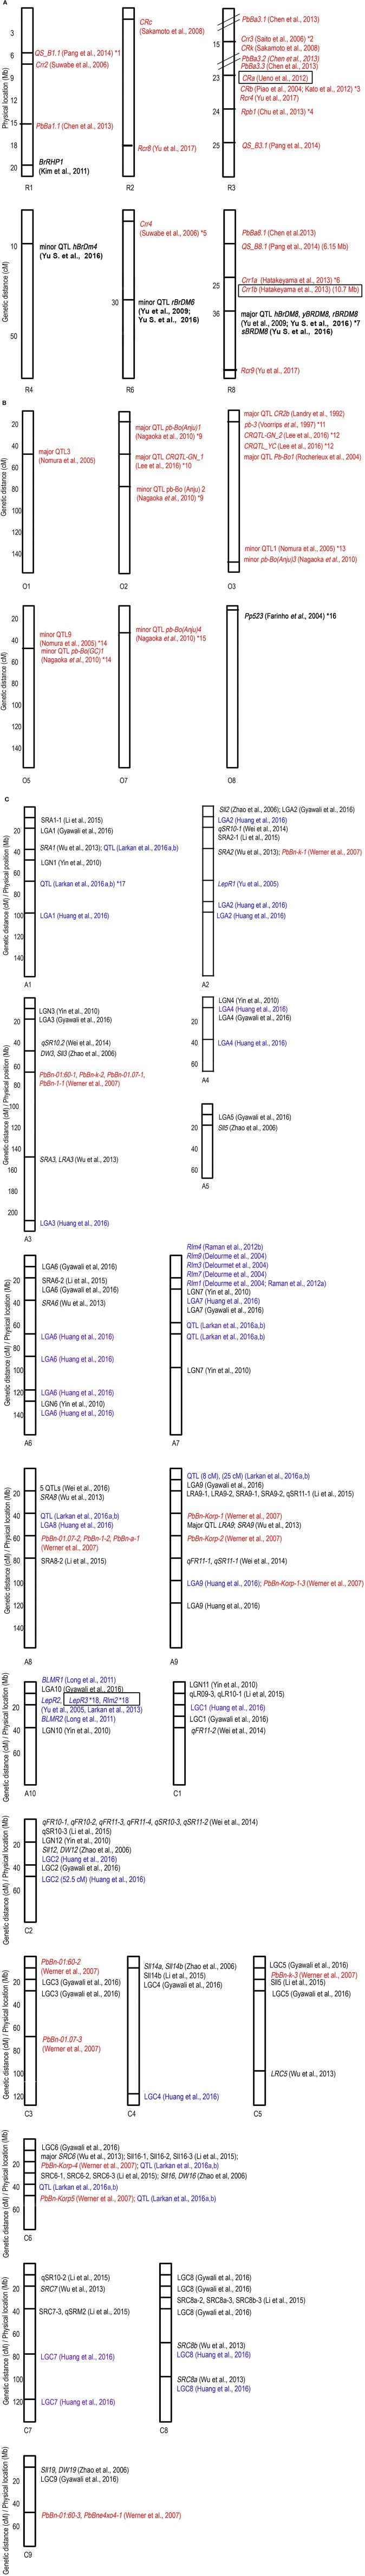
R genes/QTL mapped on B. rapa
(A), B. oleracea
(B), and B. napus
(C). Each vertical rectangular is a chromosome, with the chromosome name followed by chromosome number at the bottom. Black font denotes R genes/QTL mapped for S. sclerotiorum, blue font L. maculans, red font P. brassicae and bold black font H. parasitica. Boxed R gene is cloned. Where genetic distance applies, the chromosome position is stated in parentheses at the end of the locus. *1, Independent minor loci, homologous to A. thaliana chromosome 3; *2, Crr3 is independent of Crr1 and Crr2;
*3, Syntenic with A. thaliana chromosome 4. Crr1 and Crr2 also share the same syntenic region; *4, Close to CRa and CRb, also known as Rcr1 (Chu et al., 2014), predicted as TIR-NBS-LRR (Yu F. et al., 2016); *5, Independent of Crr1, Crr2, and Crr3; *6, Two genes, Crr1a and Crr1b were identified at originally single Crr1 locus; *7, All at the same locus and are identical to major QTL BraDM (Yu et al., 2009); *8, Candidate gene, Bra016457, is serine/threonine (S/T) kinase. The major QTL in *7 and *8 lie between 17.6 and 17.8 Mb on chromosome R8; *9, Syntenic with CRc on chromosome R2; *10, Strong collinearity with chromosome A2 in B. rapa where CRc gene is located. Also overlap with pb-Bo(Anju)1; *11, Identified by Voorrips et al. (1997) but mapped on chromosome O3 by Nagaoka et al. (2010); *12, CRQTL-GN_2 (15.5–24.3 cM) and CRQTL_YC (8.5–38.1 cM) have similar location. Syntenic regions for these two QTL are on chromosome R3 (Crr3, CRk, CRa, and CRb), R8 (Crr1); *13, Same linkage group with QTL-LG1 (Moriguchi et al., 1999); *14, May be the same locus; *15, Closely linked to CRb, homologous to chromosome R3; *16, Adult resistance; *17, Field resistance for L. maculans. Candidate gene is cysteine rich RLK; *18, LepR3 and Rlm2 are allelic variants.